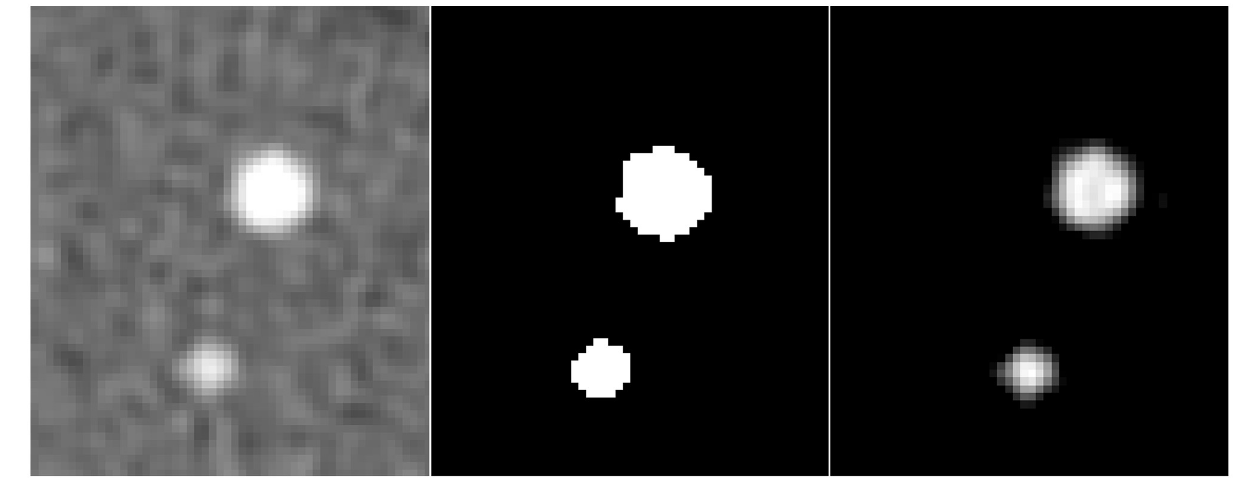
Fig 5. Left: Single CT image slice showing the CEORA phantom with a large and medium lesion (98.2 and 21.2 mm 3 ) with HA density of 400 mg/cm 3 ; Middle: Segmentation obtained using C-CS; Right: Segmentation obtained using